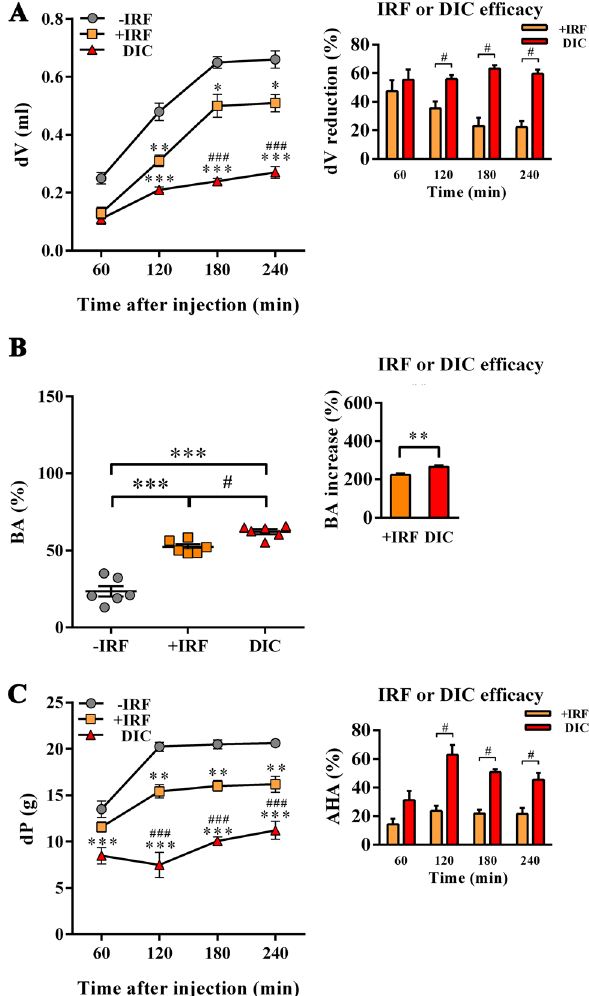
Figure 10. Influence therapeutic exposure to IR fibre on paw edema, mechanical stimulus-evoked pain behaviours and burrowing behaviour of rats with carrageenan-inflamed paws. Immediately after their right hind paws were injected with carrageenan rats were transferred in cages with IR fibre bedding (+IRF rats) or left in standard wooden shaving bedding (−IRF rats). Right paws from a randomly chosen group of −IRF rats were administered with 5 mg/kg Diklofen per os (DIC rats). (A) Line graph indicates the increase in paw volume after carrageenan injection (dV) in respect to that before the administration of carrageenan. Bar graph shows the dV reduction (%) in +IRF and DIC rats relative to −IRF rats (see “Material and methods”). ( B) Scatter plot indicates the burrowing activity (BA) after carrageenan injection in +IRF, −IRF and DIC rats. Bar graph shows the increase in BA (%) in +IRF and DIC rats relative to −IRF rats (see “Material and methods”). (C) Line graph indicates the difference between the paw withdrawal thresholds after and before carrageenan injection (dP) in +IRF, –IRF and DIC rats. A bar graph shows the antihyperalgesic activity (AHA) of exposure to IR fibre bedding in a treatment paradigm (+IRF) and Diclofenac treatment (DIC) in rats with carrageenan-induced paw inflammation (see Material and Methods). All line graphs and bar graphs were created using GraphPad Prism version 7.00 for Windows, GraphPad Software, La Jolla, California, USA (https ://www.graph pad.com). Results are expressed as mean ± SEM. n = 6 rats/group.* p ≤ 0.05, ** p ≤ 0.01 and *** p ≤ 0.001 vs −IRF; and # p ≤ 0.05, ## p ≤ 0.01 and ### p ≤ 0.001 vs